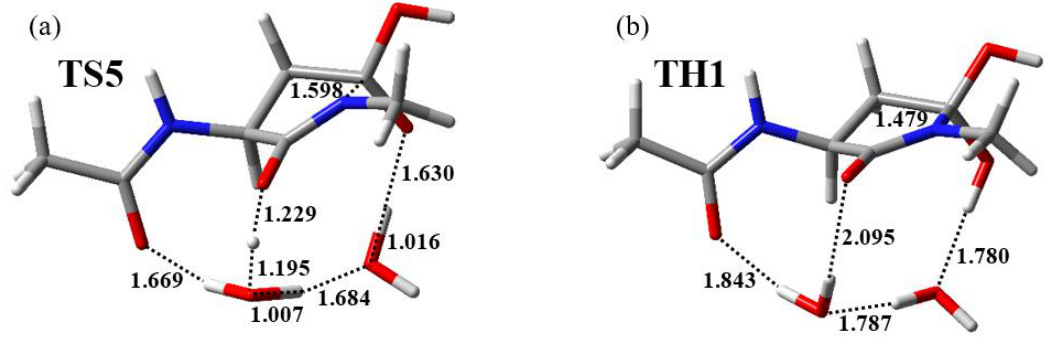
Figure 4. Optimized geometries of ( a ) TS5 ( φ = −113°, ψ = −96°, χ 1 = −176°) and ( b ) TH1 ( φ = −100°, ψ = −138°, χ 1 = 157°). Selected interatomic distances are presented in angstroms (Å). Carbon, hydrogen, nitrogen, and oxygen atoms are illustrated in gray, white, blue, and red, respectively.